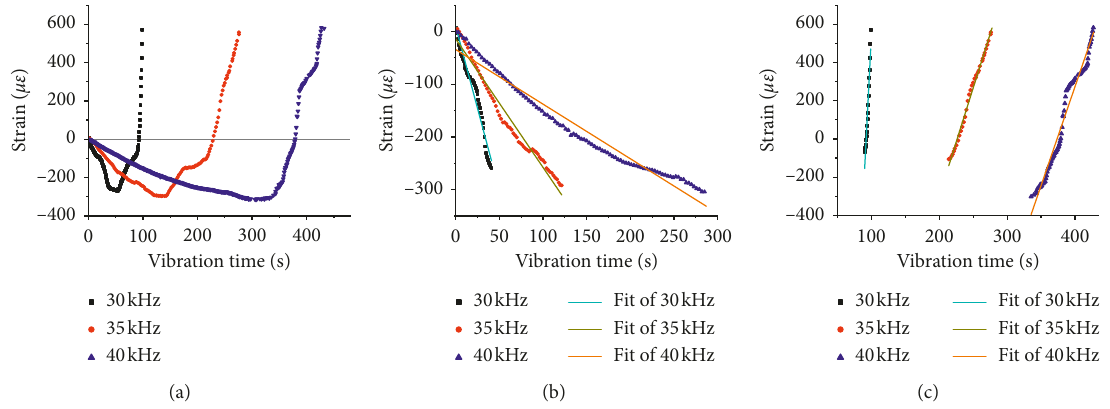
Figure 7: Strain of samples under ultrasonic vibration with different frequencies. (a) Whole strain process. (b) Descendant process of strain. (c) Ascendant process of